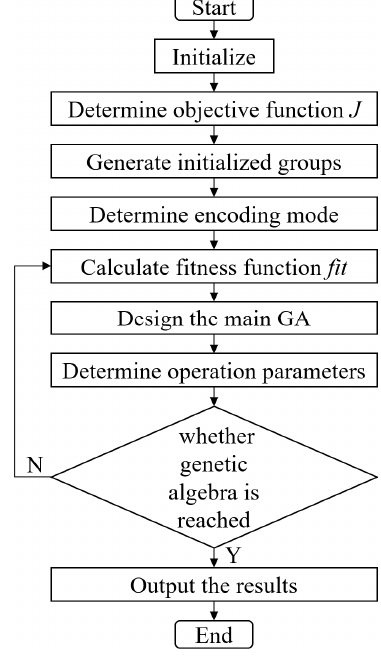
Figure 2. The flowchart of